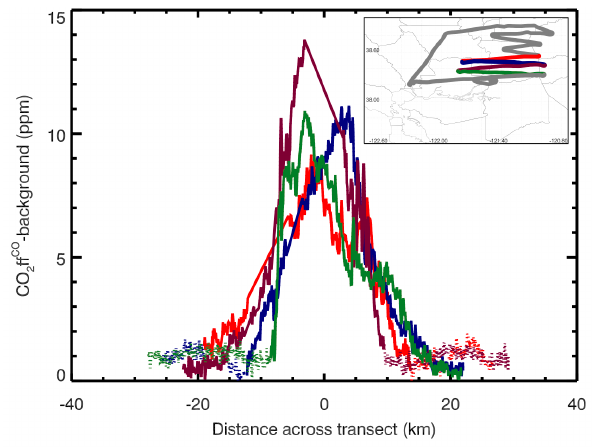
Fig. 9. X meas (CO 2 ff CO – background CO 2 ) used to integrate for the flux calculation for each of four downwind transects in SAC227. Solid lines indicate the areas inside the plume for each transect. Inset, flight map showing the individual transects, with the same color